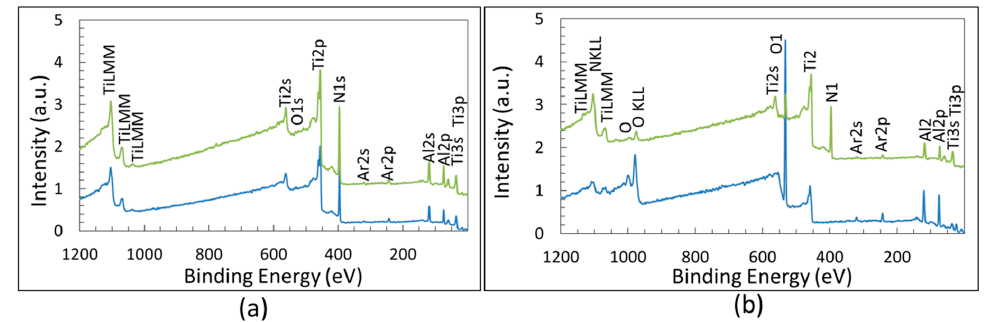
Figure 4. XPS survey of samples after surface cleaning: ( a ) TiAlN1 (blue) and TiAlN3 (green) as deposited; and ( b ) TiAlN1 (blue) and TiAlN3 (green) after 40 cycles at 950 °C in burner rig.